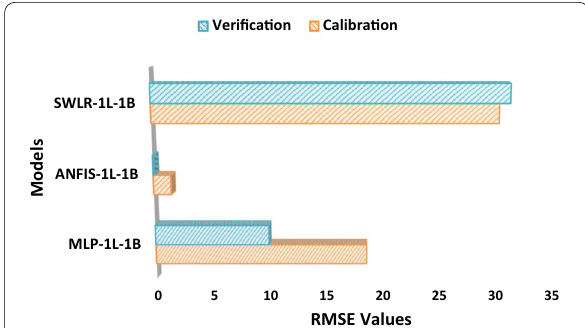
Fig. 2 ComparativeRMSE values of the models in modelling